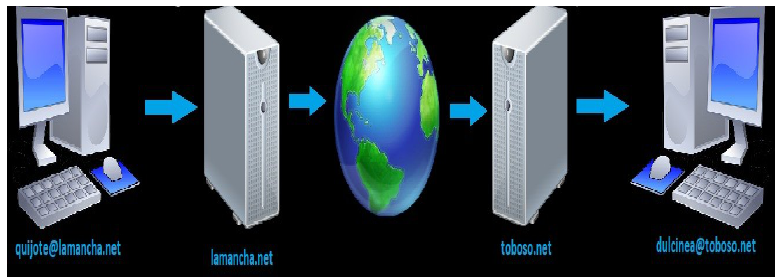
Figure 4. Connection process between two users via the Extensible Messaging and Presence Protocol (XMPP).